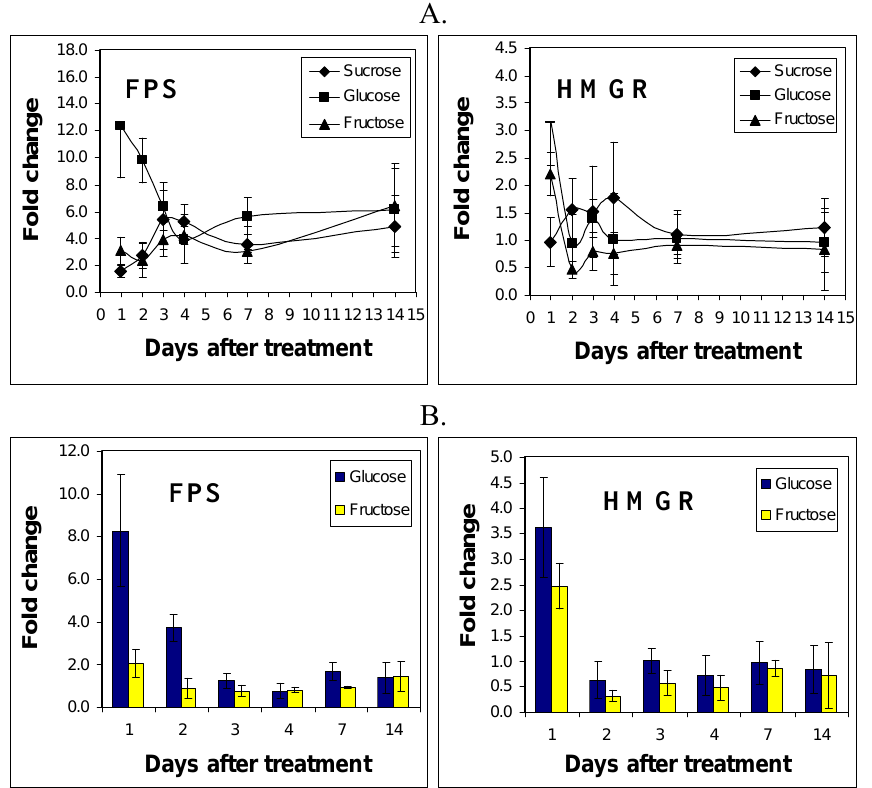
Figure 2. (A) Changes in HMGR and FPS in A. annua seedlings grown 14 days in glucose, fructose, or sucrose relative to day zero. (B) Relative response of HMGR and FPS in A. annua seedlings grown in glucose or fructose and compared to growth in sucrose. Bars are ±